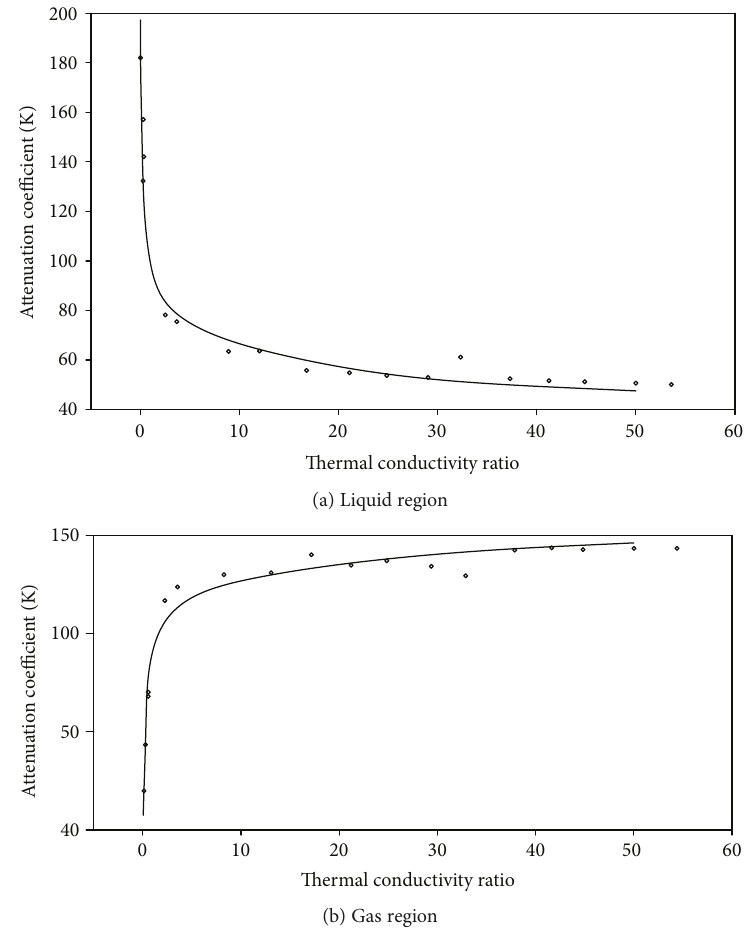
Figure 6: Curve of attenuation coe ffi cient versus thermal conductivity ratio.